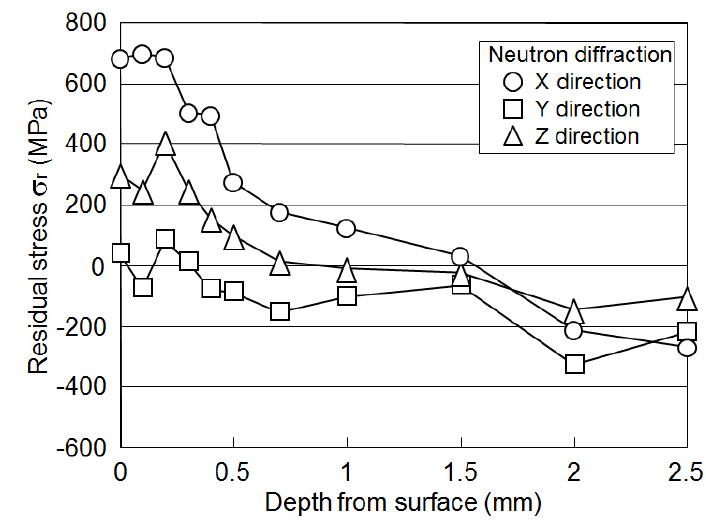
Figure 9. Residual stress distribution in near-surface of water jet peened type 304 stainless steel plate.